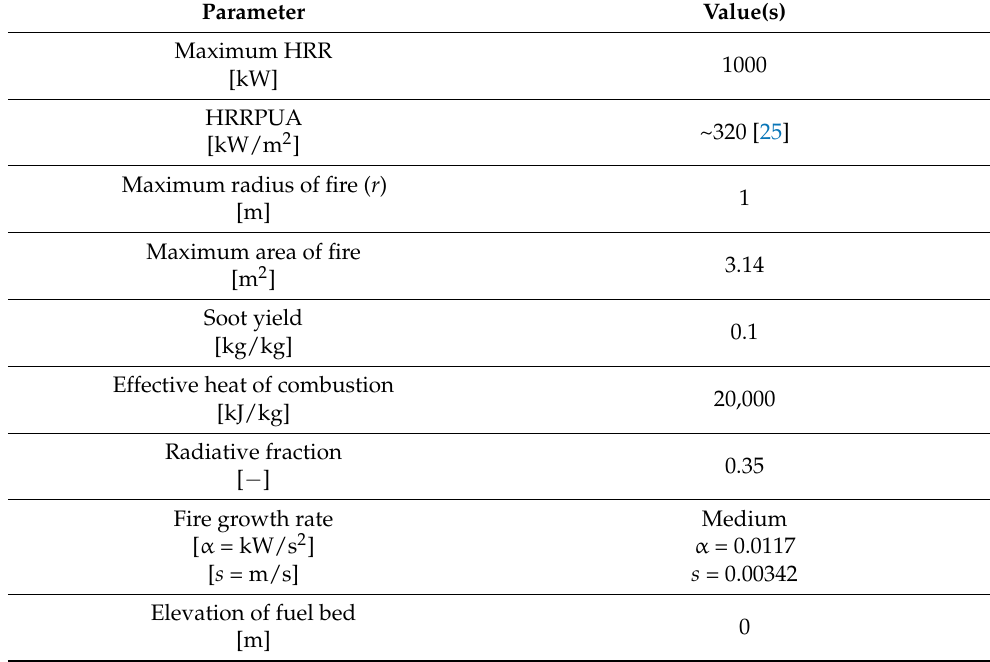
Table 1. Summary of the design fire properties used in the established timeline modelling.